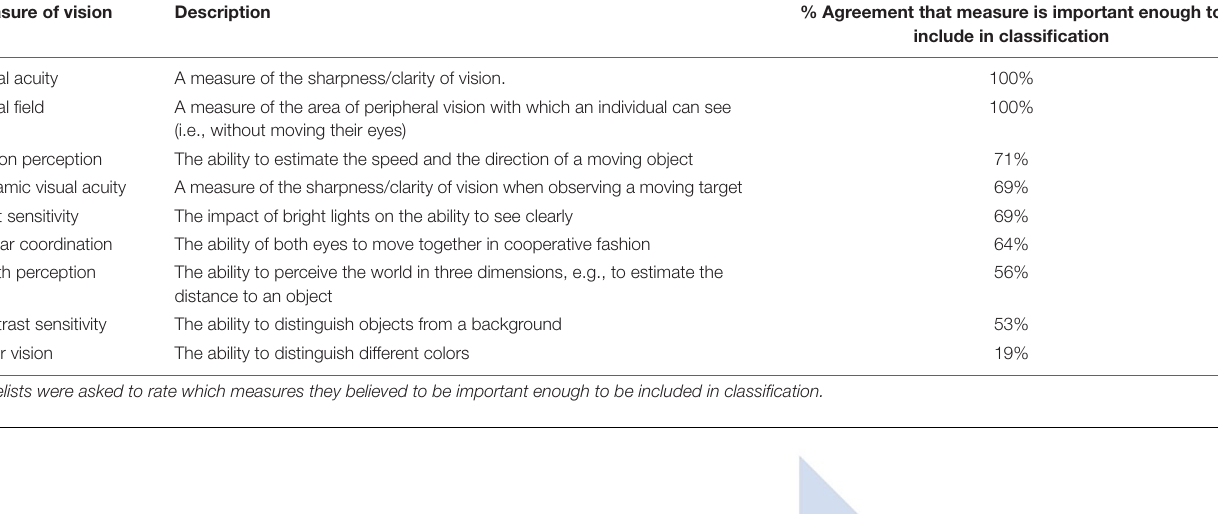
TABLE 3 | List of additional measures of vision impairment considered by the panel for inclusion in classification. Measure of